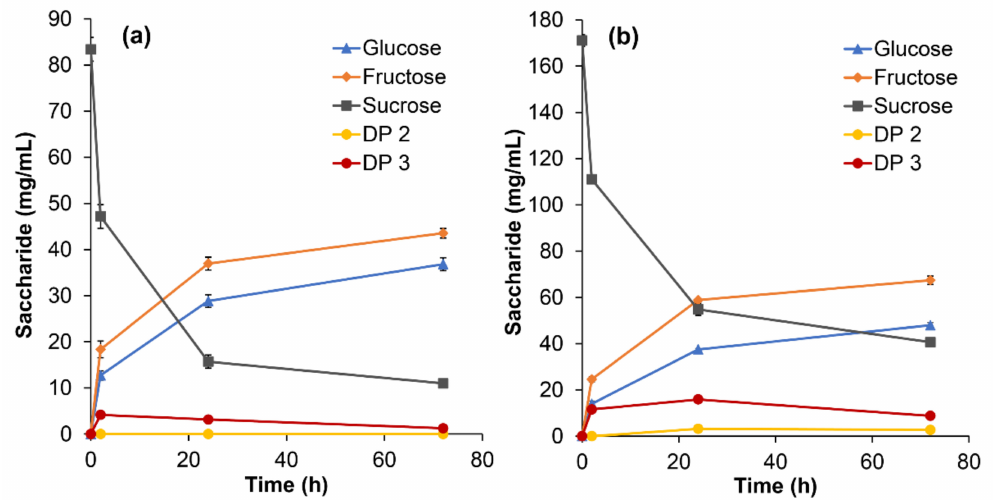
Figure 3. Transglycosylation of sucrose by Ba AG2. 20 µ g/mL of the enzyme was reacted with 250 mM ( a ) or 500 mM ( b ) of sucrose. Samples from the reaction mixtures were withdrawn at designated time points, heated to terminate the reaction and analyzed for sugar composition by HPLC as described in Materials and Methods, Sections 2.4 and 2.6. Concentrations of detected saccharides at each time point are shown. Products were specified using glucose, fructose, sucrose, isomaltose, and melezitose as references. Transglycosylation products with DP 2 (other than sucrose and its isomers) and DP 3 are marked with yellow or red circles, respectively. SDs of two to three HPLC measurements at each time point are indicated by error